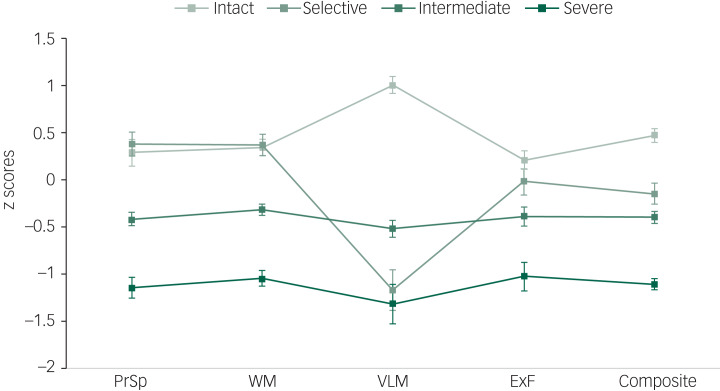
Cognitive profiles (domain mean and standard error) of the four subgroups (cognitively intact; selective deficit in verbal learning and memory; intermediate impairment across all domains; and severe global impairments). PrSp, processing speed; WM, working memory; VLM, verbal learning and memory; ExF, executive functioning; Composite, composite cognitive score.